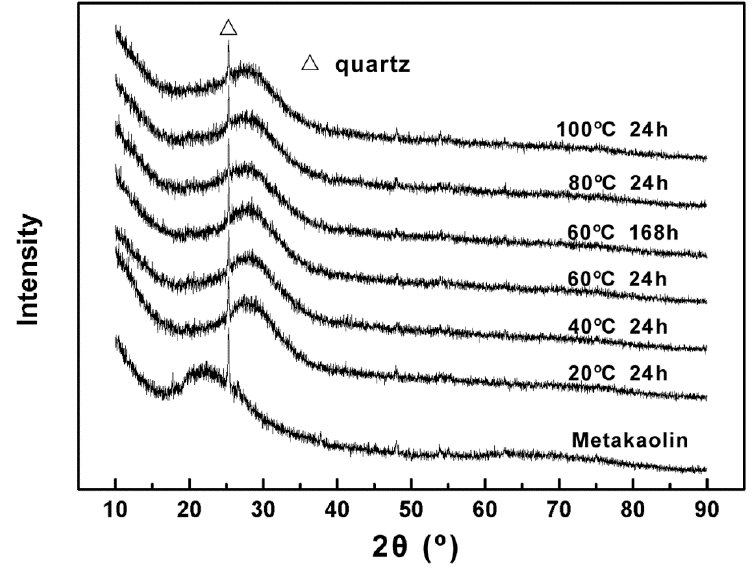
Figure 2. X-ray diffractograms of metakaolin and geopolymers cured at different temperatures and times.